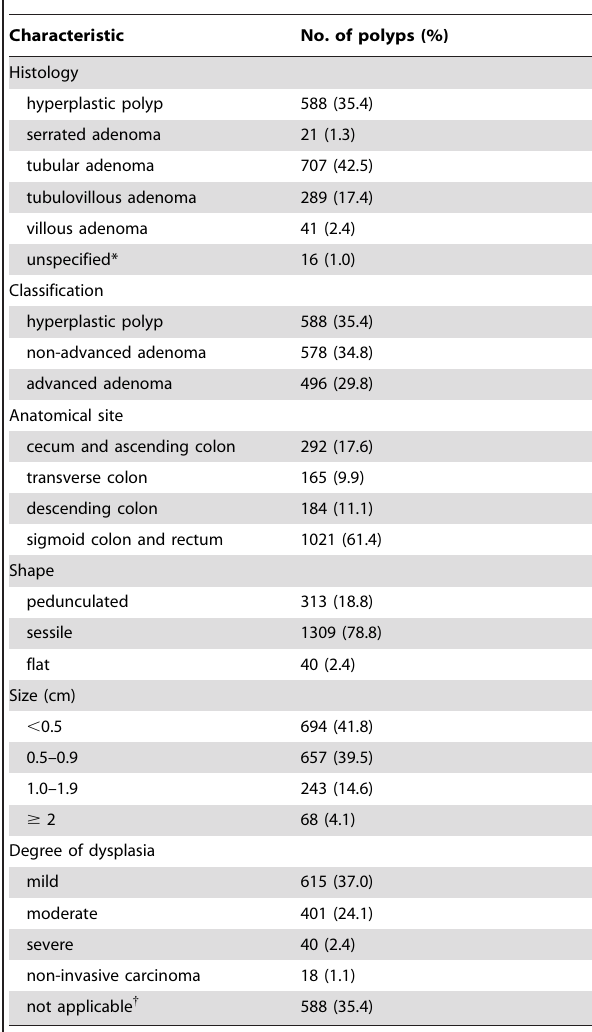
Table 3. Characteristics of colorectal polyps at index colonoscopy (n= 1662).